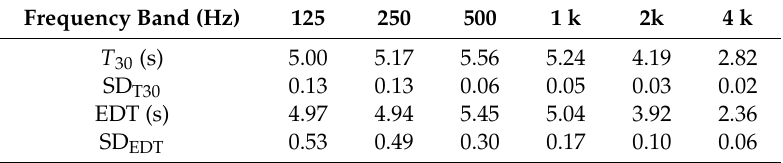
Table 4. Reverberation time ( T 30 ) and Early decay time (EDT) values 1 measured under unoccupied conditions at the York Minster’s Chapter House, together with their standard deviation